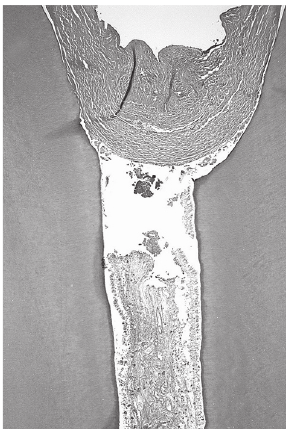
Figure 1. Group I (collagen). Absence of dentine bridge and degenerated pulp remnant in cervical third. HE; magnification, X24.